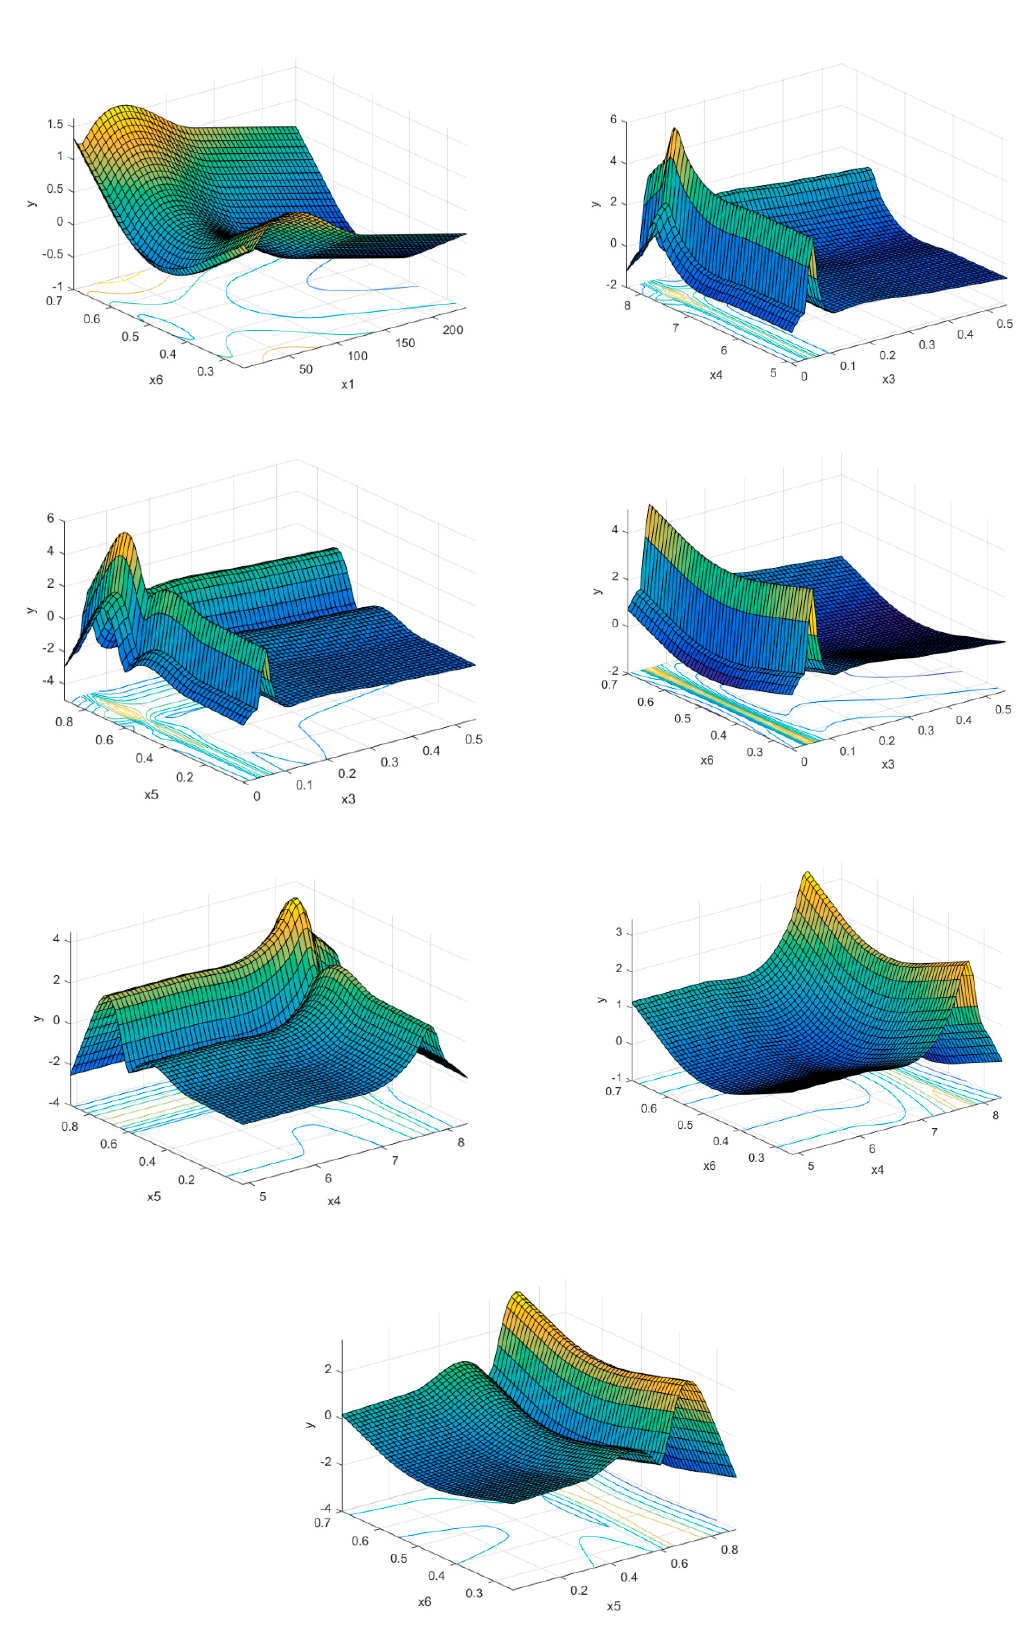
Figure 9. The various effects of variables on MARS models based on the piecewise-cubic method. Table 5. Results of slope deformation of earth dam predicted by the MARS model based on the piecewise-cubic method.